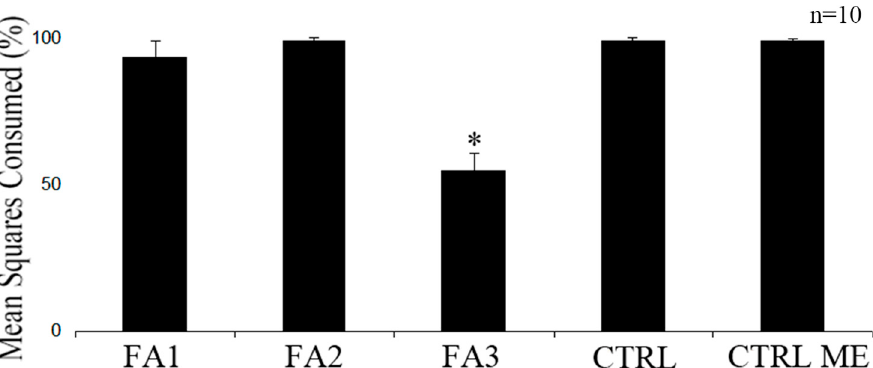
Figure 2. Effect of fatty acid fractions (FA1, FA2 and FA3) from EA extract of P. gymnospora on the consumption by L. variegatus . Controls: only grounded U. fasciata with (CTRL ME) and without methanol (CTRL). Asterisk indicate distinct consumption ( p < 0.05). Values are means and standard deviation of n = 10.